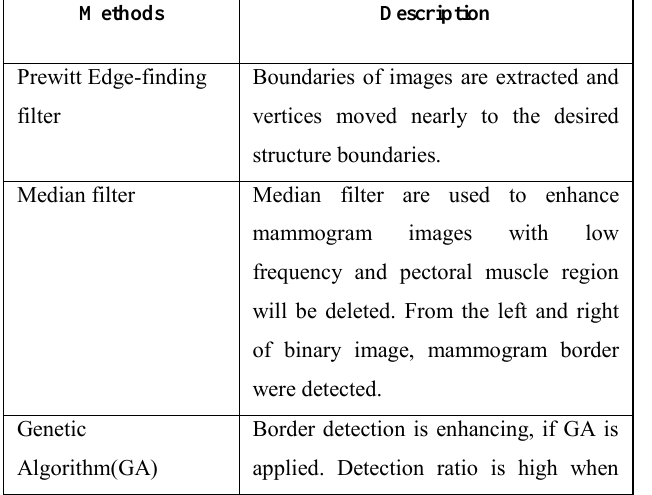
Table 1.2 An Overview of Image